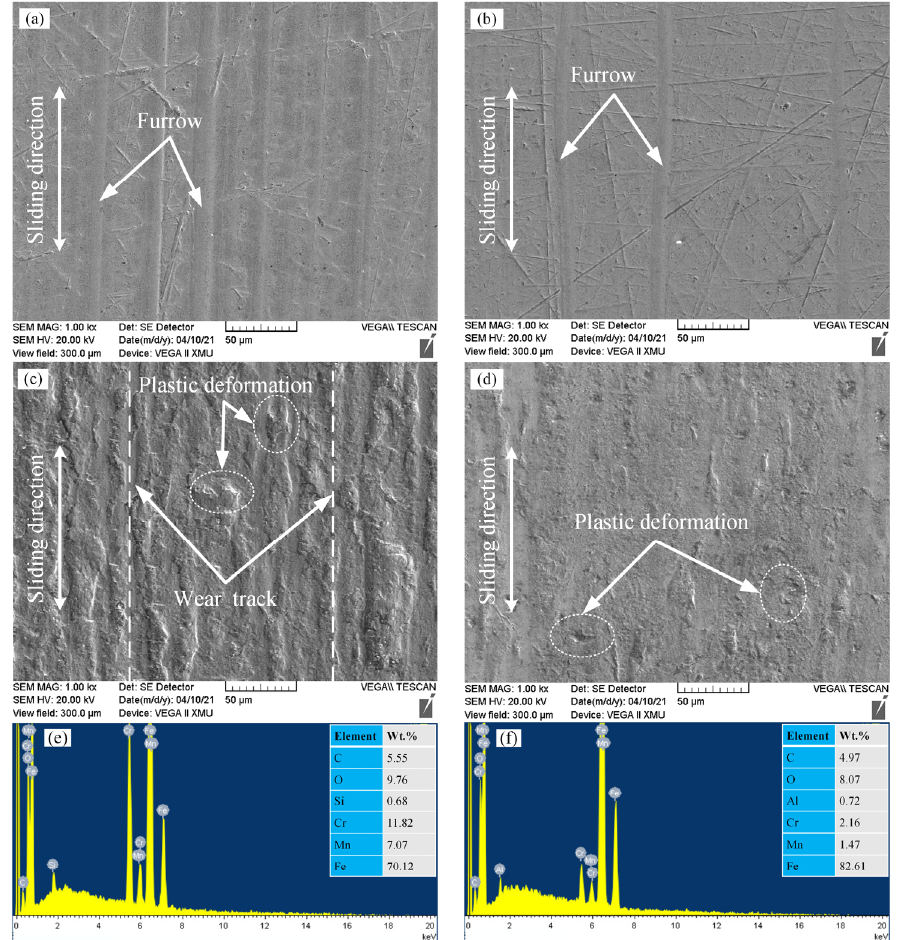
Figure 8. SEM morphologies of the ( a ) cladding layer and ( b ) nitriding layer under starved lubrication of 100 N, ( c ) cladding layer and ( d ) nitriding layer under dry sliding of 10 N. EDS spectra of the ( e ) cladding layer and ( f ) nitriding layer under starved lubrication.